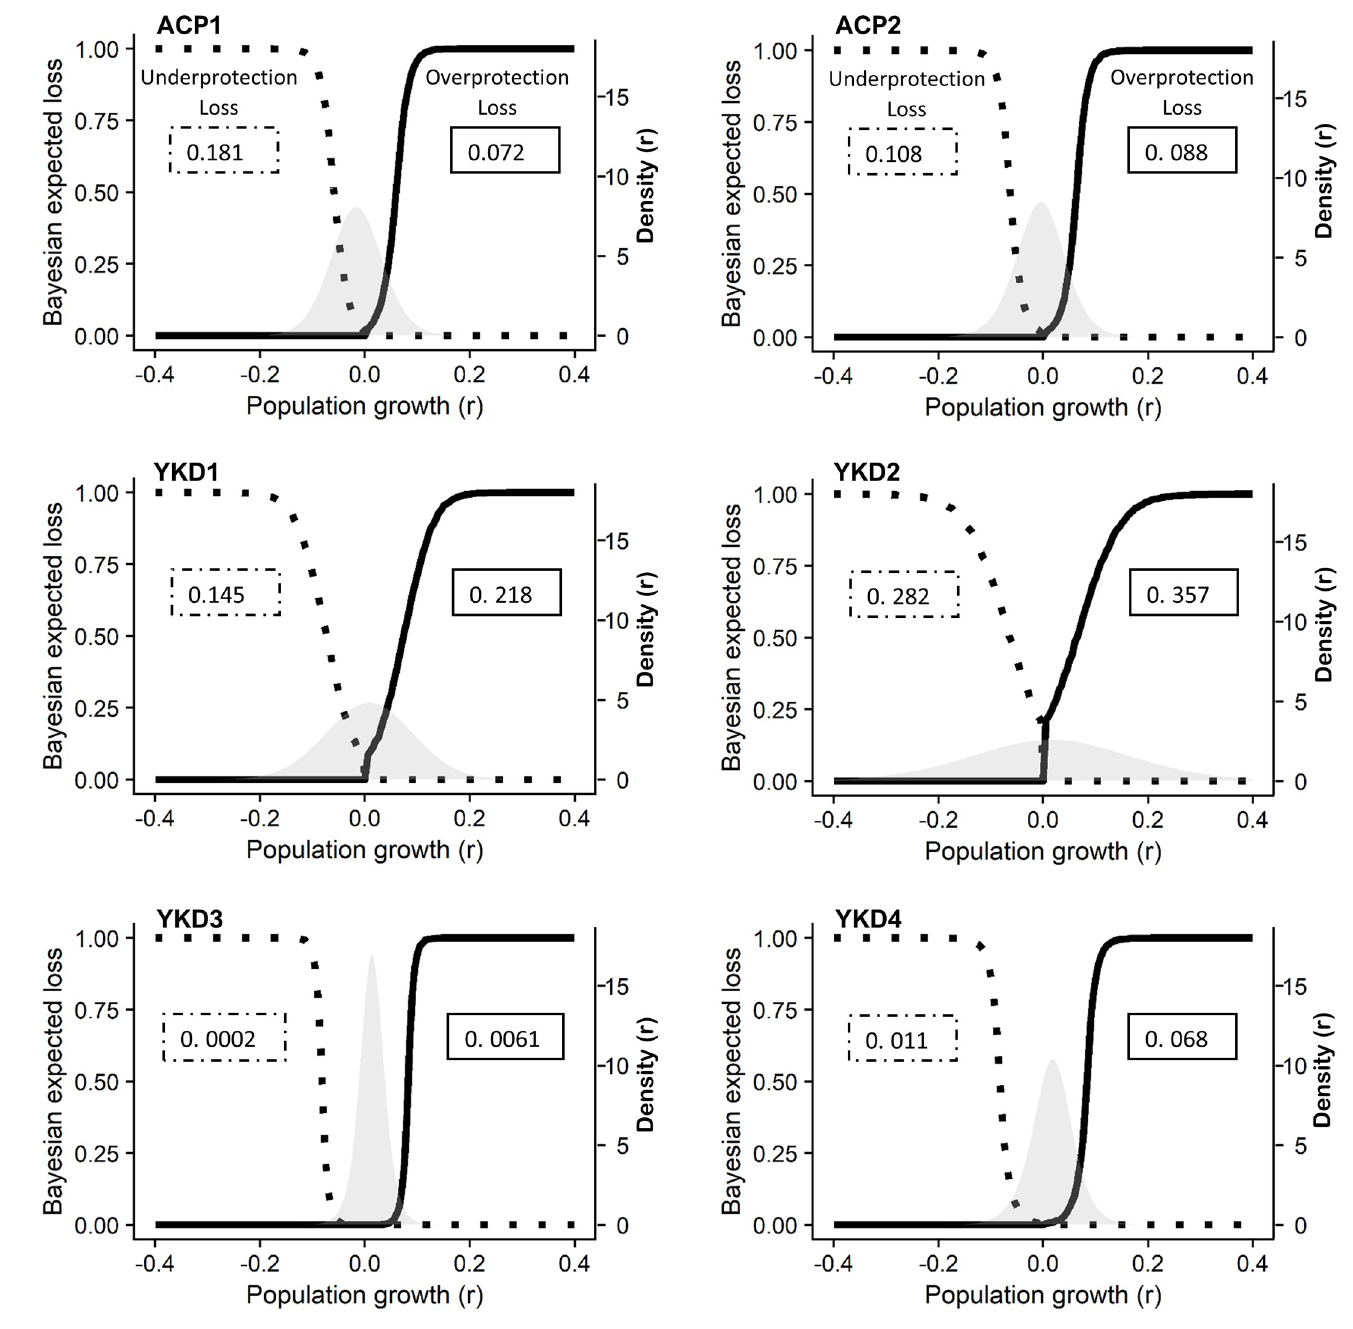
Fig 2. Loss functions and posterior distributions of population growth rate (r) generated from state-space models of abundance for spectacled eiders breeding on the Arctic Coastal Plain (ACP) and Yukon Kuskokwim Delta (YKD). Loss functions were generated using the probability of quasi-extinction given population size, growth rate, and process variation. The dotted line represents the under-protection loss function (i.e., loss if decision were to delist given negative population growth) and the solid line is the over protection loss function (i.e., loss if the decision were to maintain status given positive population growth). Gray distributions show the posterior density of population growth rate ( r ) estimated by a Bayesian state-space model for the time series from 2007 to 2019. As part of the recovery criteria, spectacled eiders will be considered for delisting if overprotection (value in solid line box) is greater than underprotection (value in dashed line box). Greater overprotection error indicates that we are more likely to provide too much protection to the species than we are to provide too little protection to the species.